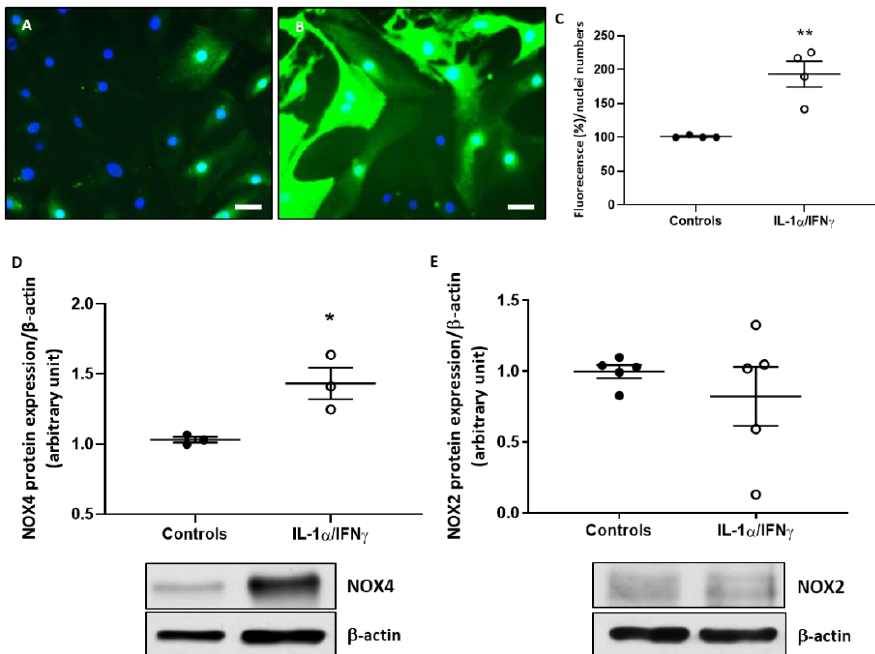
Figure 1. ROS production and NOX4 protein expression increased in primary cultures of human thyrocytes treated with Th1 cytokines, mimicking Hashimoto’s thyroiditis, while NOX2 protein expression did not change. Human thyrocytes were treated for 24 h with Il-1α and IFNγ. Cells were immersed in a 1-µM solution of CM-H2DCFDA for 30 min. Nuclei were stained by Hoescht. Images shown are representative of each condition. The picture on the left shows non-treated control thyrocytes ( A ) and Th1 cytokines-treated thyrocytes are displayed on the right ( B ). Scale bar = 10 µ m. ROS levels were increased in thyrocytes treated with Th1 cytokines compared to controls. Quantification of ROS expression was analyzed using ImageJ software ( C ). Fluorescence was quantified and normalized to the number of nuclei. Results are expressed as means ± standard error of the mean (SEM) from four experiments ( n = 4). ** p < 0.01 compared to control. NOX4 ( D ) and NOX2 ( E ) protein expressions were quantified by Western blot technique in human thyrocytes treated or not with Th1 cytokines. Th1 cytokines induced a significant increase of NOX4 expression while NOX2 did not change. Densitometric values were normalized against the β -actin level. Results are expressed as means ± SEM from three (NOX4) and five (NOX2) experiments ( n = 3–5) at least in duplicate. * p < 0.05 compared to control. A representative blot is